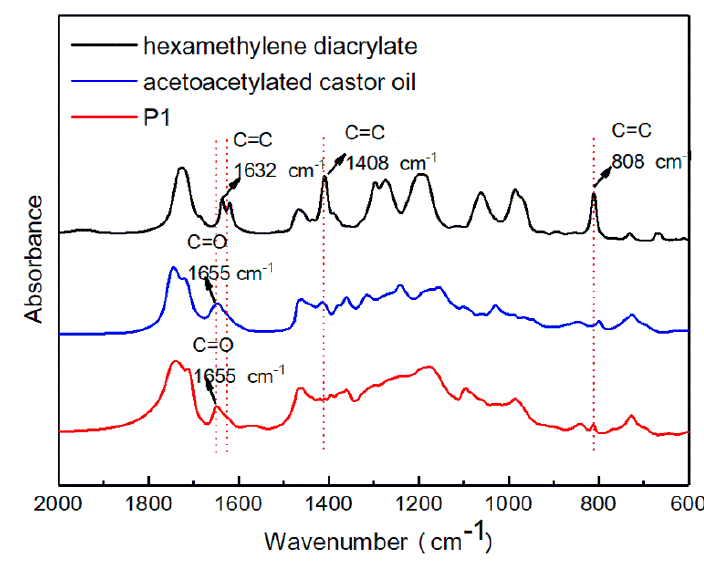
Figure 3. The FTIR characterization of acetoacetylated castor oil, hexamethylene diacrylate and the film (P1).